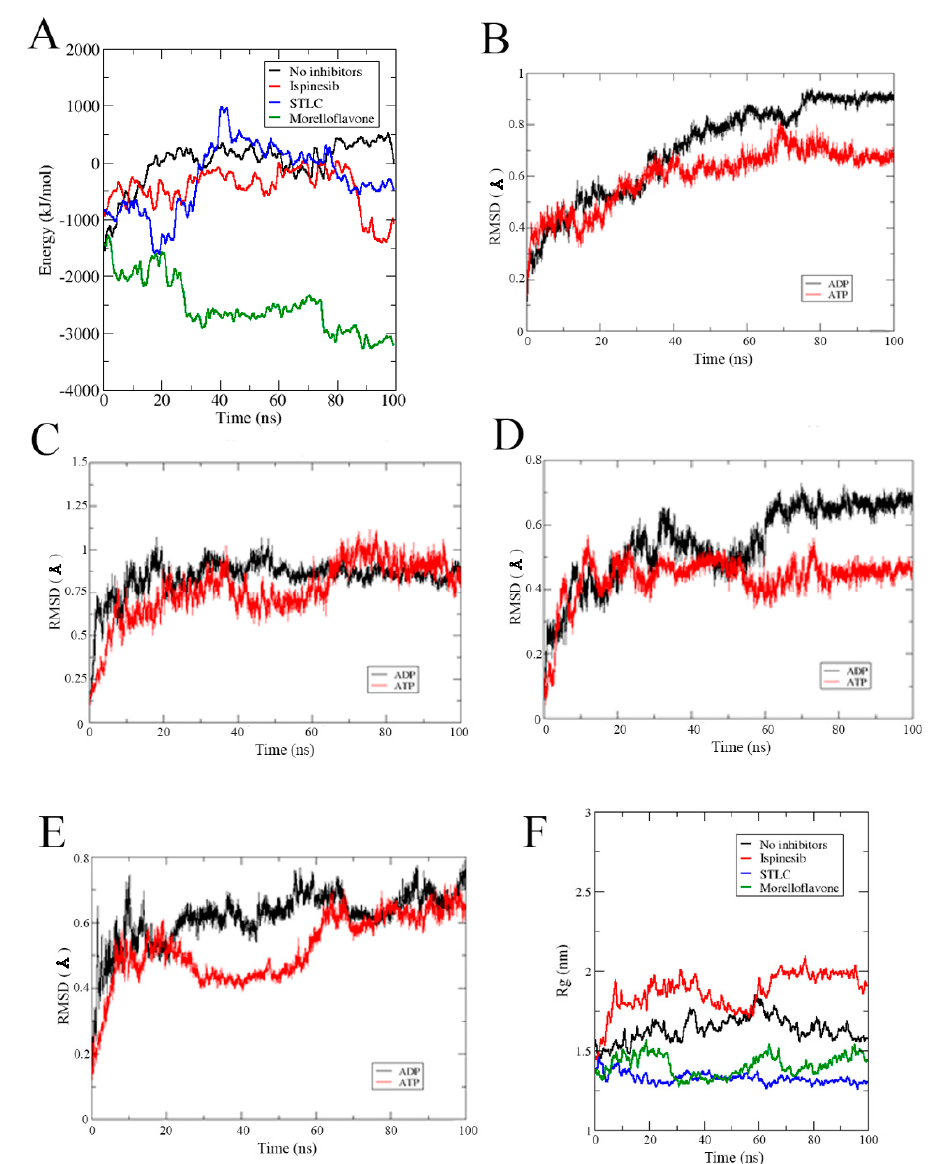
Figure 8. ( A ) Binding affinity of ADP with Eg5 during MD trajectories calculated using the MM/PBSA method on the 100 ns trajectories. RMSD profiles of the active site in ( B ) Eg5-ADP versus Eg5-ATP, ( C ) Eg5-ADP-ispinesib versus Eg5-ATP-ispinesib, ( D ) Eg5-ADP-STLC versus Eg5-ATP-STLC, and ( E ) Eg5-ADP-MF versus Eg5-ATP-MF. ( F ) Rg of Eg5-ATP complexes.